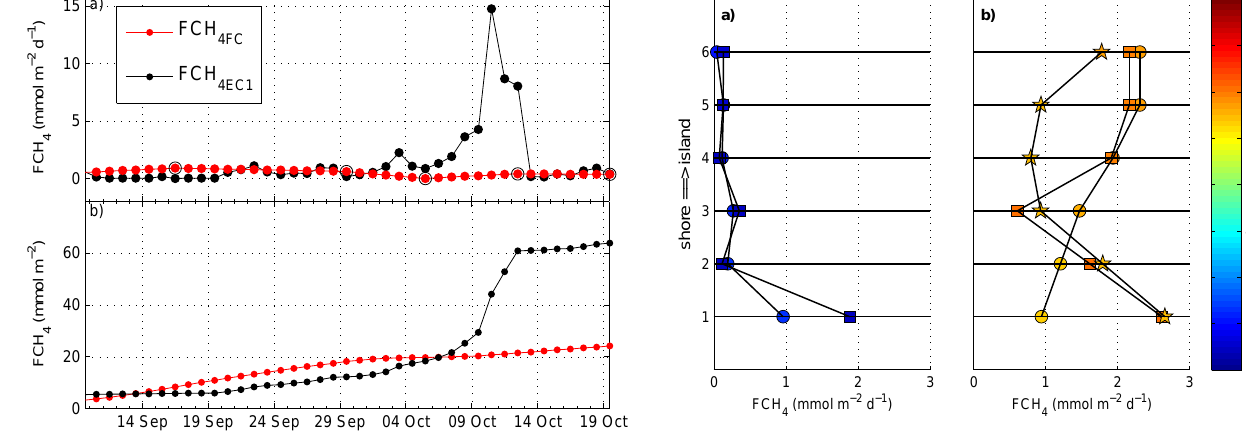
Figure 5. FCH 4FC measurements conducted along a transect from the shore to the island of Rättarharet marked with numbers 1–6 in Fig. 1 for (a) 12 June 2012 19:30 to 13 June 2012 4:00 and (b) 14 June 2012 11:00 to 14 June 2012 19:00. The colours represent the wind speed and the different symbols mark chambers measured during the same